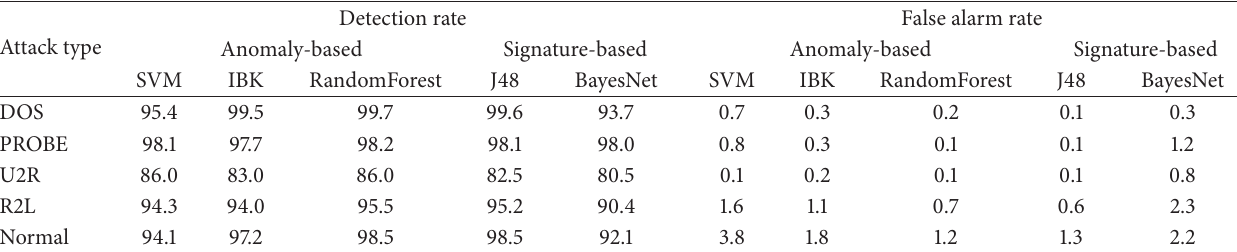
Table 6: Detection rate and false alarm rate of each classifier for test data.